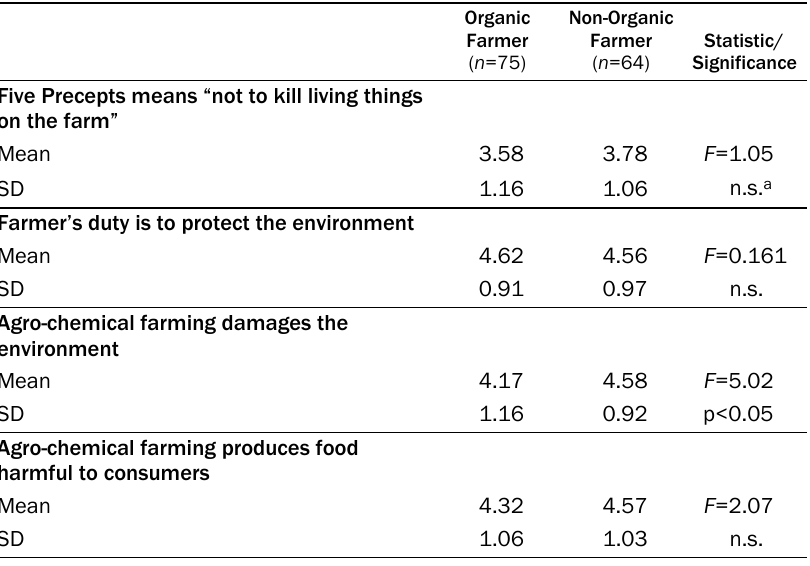
Table 3. Differences Between the Environmental Views of Organic and Non-Organic Farmers